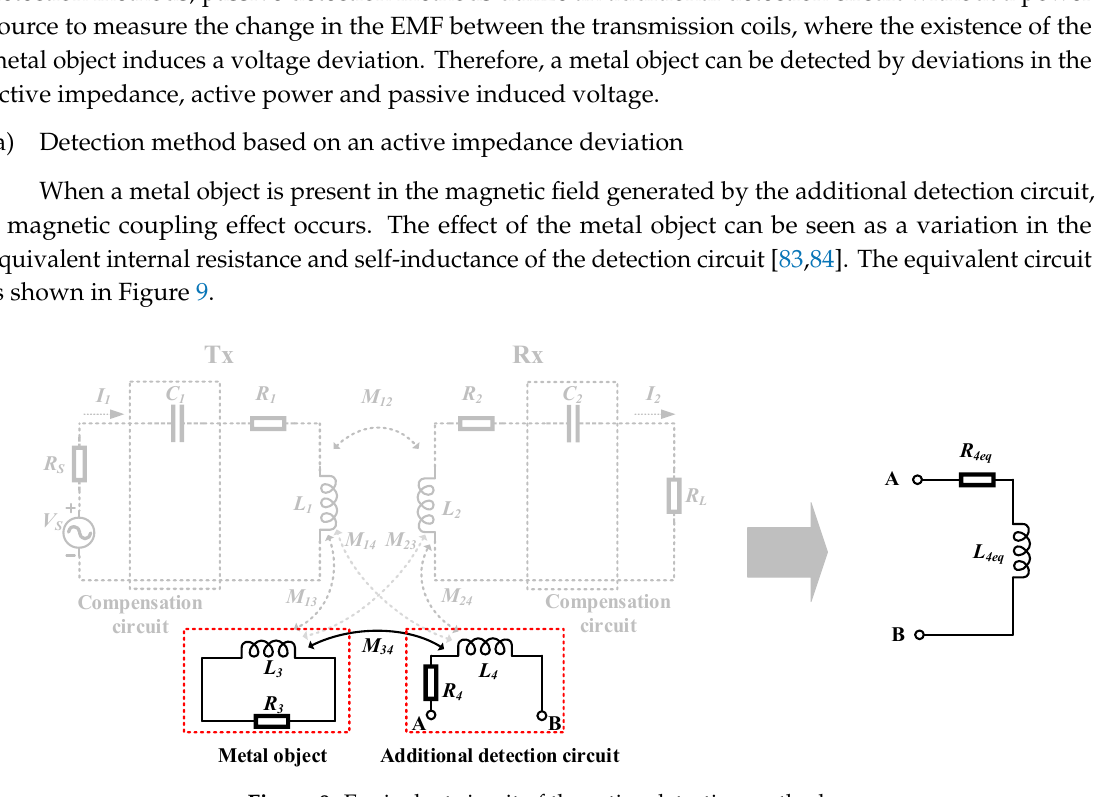
Figure 9. Equivalent circuit of the active detection method.